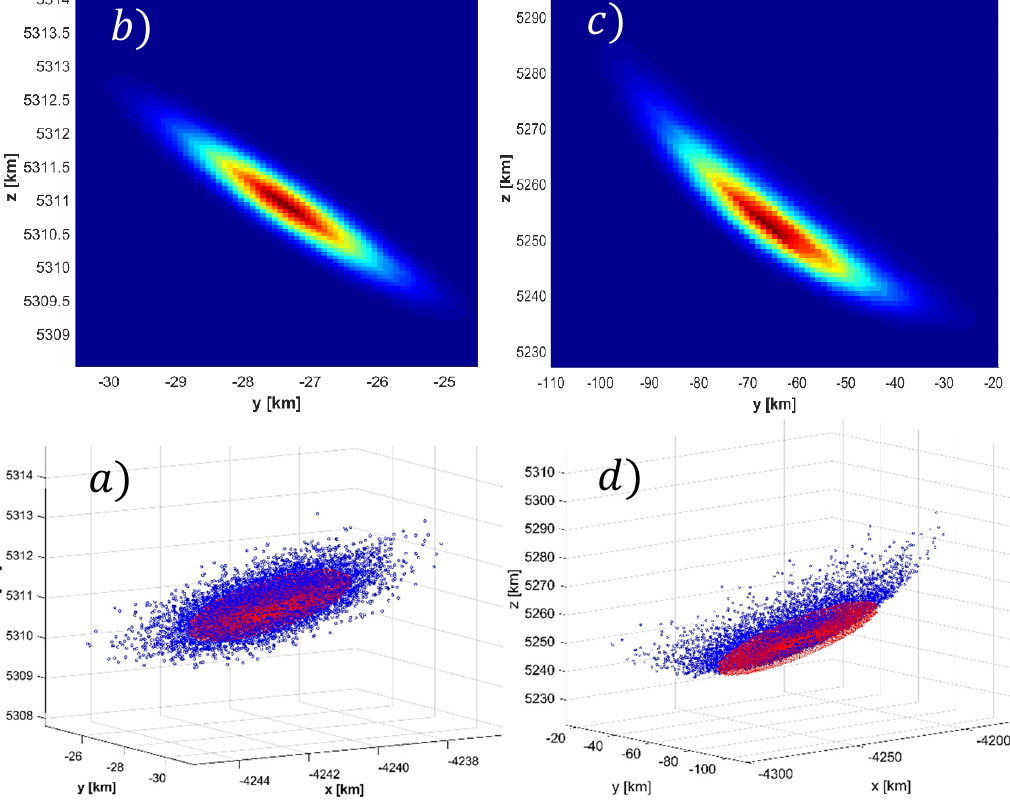
Figure 11. Monte Carlo generated distribution and corresponding contour maps for the 6 cm debris. Clockwise from bottom left: ( a ) 99%CVM Monte Carlo distribution ( b ) 99%CVM Contour Map, ( c ) >> 99% CVM Confidence Interval Contour Map ( d ) >> 99% CVM Confidence interval Monte Carlo distribution.